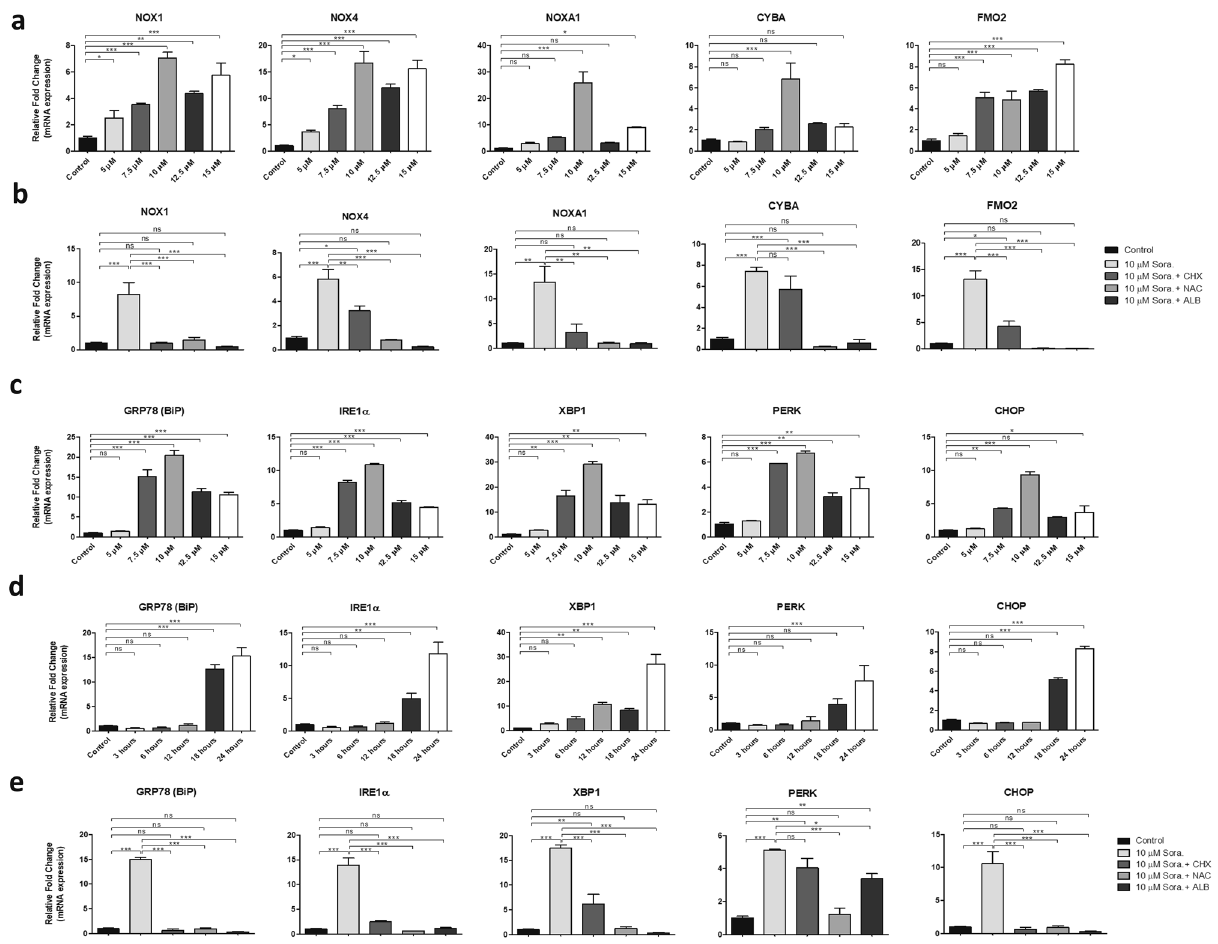
Figure 6. Influence of Sorafenib on ROS and ER stress signalling. ( a ) qPCR showing different concentration of sorafenib induced fold changes of relative mRNA expressions of ROS generating enzyme gene such as NOX1, NOX4, NOXA1, CYBA, FMO2 for 24 h. ( b ) The relative mRNA expression of 10 µM sorafenib induced ROS generating enzyme genes after 24 h without and with pre-treatment of CHX, NAC and albumin (ALB). ( c ) qPCR showing different concentration of sorafenib induced fold changes of relative mRNA expression of ER stress or unfolded protein response (UPR) markers such as GPR78 (BiP), IRE1α, PERK, XBP1 and CHOP after 24 h. ( d ) Time dependent relative mRNA expression of 10 µM sorafenib induced ER stress markers were shown in different concentration and different time point up to 24 h. ( e ) The relative mRNA expression of 10 µM sorafenib induced ER stress markers without and with pre-treatment of CHX, NAC and albumin. Fold changes are normalised with expression of 18S rRNA. Data represent mean ± s.d. from three independent experiments (ns > 0.05, *P < 0.05, **P < 0.01, ***P < 0.001 One-way analysis of increased mRNA expression of ROS generating enzymes in LX2 cells after 10 µM sorafenib treatment for 24 h (Fig. 6b). These results suggest the involvement of ROS signals in sorafenib induced cytoplasmic vacuolation and cell death. However, the anti-oxidant NAC was unable to supress the sorafenib induced cytoplasmic vacuolation mediated non-apoptotic cell death. To investigate the possible ER stress mediated signaling, we quantified the mRNA expression of ER stress or UPR pathway markers such as Binding immunoglobulin protein/(GPR78/BiP), inositol-requiring enzyme 10 μM sorafenib. We found that sorafenib enhanced the mRNA expression of UPR markers in a dose and time dependent manner. LX2 cells treated with the 10 μM sorafenib dose for 24 h showed the highest expression of UPR genes (Fig. 6c,d). However, the sorafenib induced upregulation of UPR genes in LX2 cells was attenuated on pre-treatment with CHX, NAC and ALB (Fig. 6e). Upon ER stress, IRE1/endoRNAse activity regulates the expression of the transcription factor cleaved XBP1 (XBP1s) 36 . Here the mRNA level of XBP1 showed a steady increase significantly from 12 h time point after 10 μM sorafenib treatment, determining a possible involvement of IRE1α-XBP1s axis to induce ER stress.